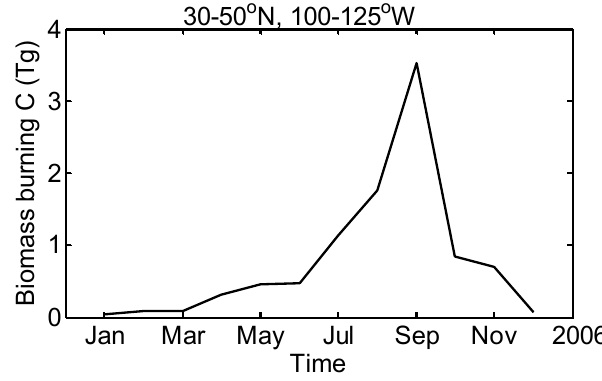
Fig. 2. GFEDv2 monthly total carbon emissions from fires in the Western US (100–125 ◦ W, 30–50 ◦ N) for